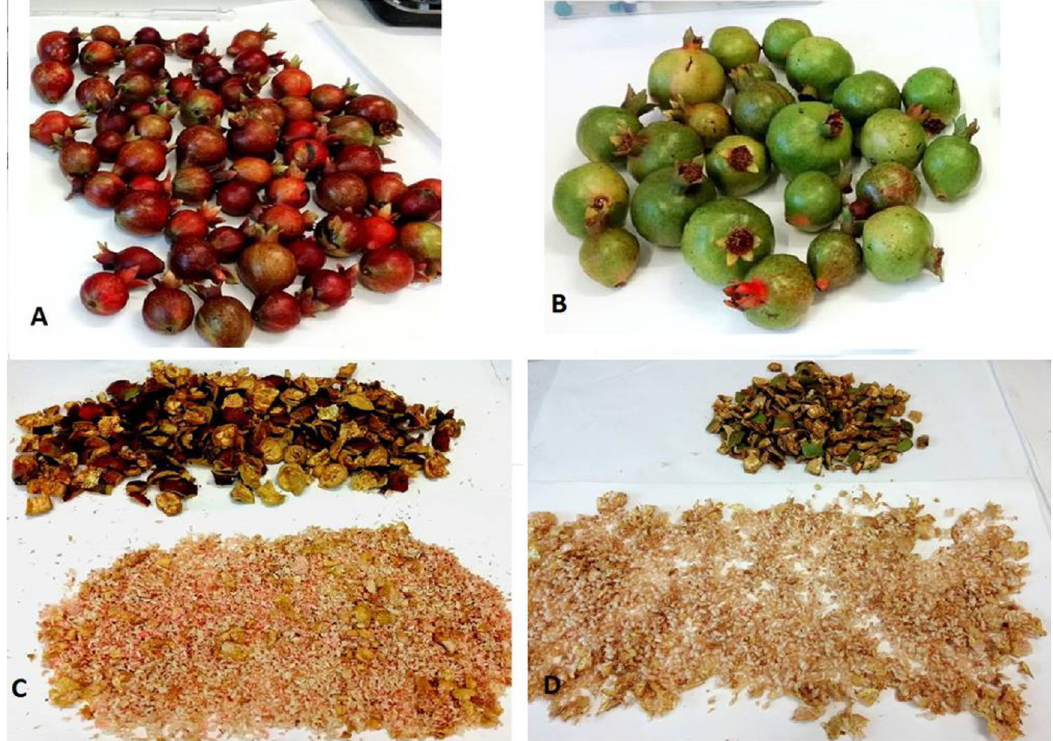
Fig 2. Immature pomegranate ‘baby red’ (A, C) and ‘baby green’ (B, D) as whole fruits and divided into peels and mesocarp/ arils ready for extractions.